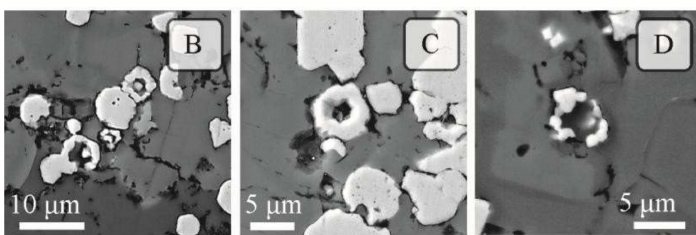
Figure A2. BSE image of finely dispersed precipitations of globular and microcrystalline pyrite in quartz– carbonate matrix of the host-rock (polished section, sample H3-56): ( A ) general view of finely dispersed pyrite accumulation; ( B – D ) typical shapes of microcrystals. They are represented by both separate euhedral crystals ( B , C ) and their isometric ( C ) and subspherical ( B – D ) intergrowths consisting of small (0.5–1.0 µ m) vesicles.